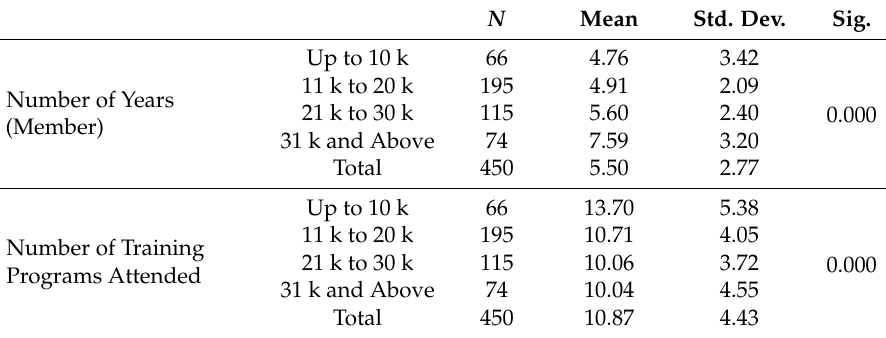
Table 5. Loan Received and Key